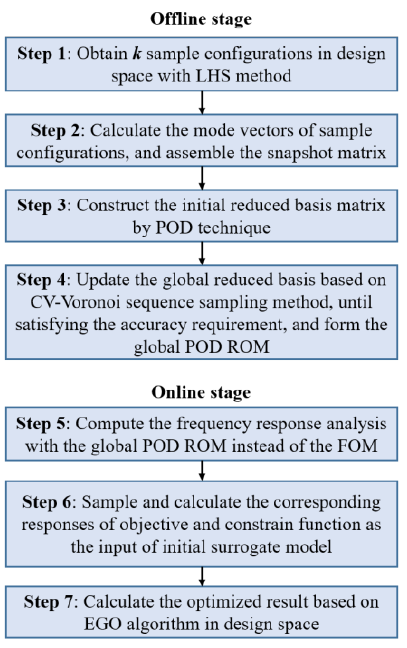
Figure 2. Flowchart of Efficient Global Optimization method.